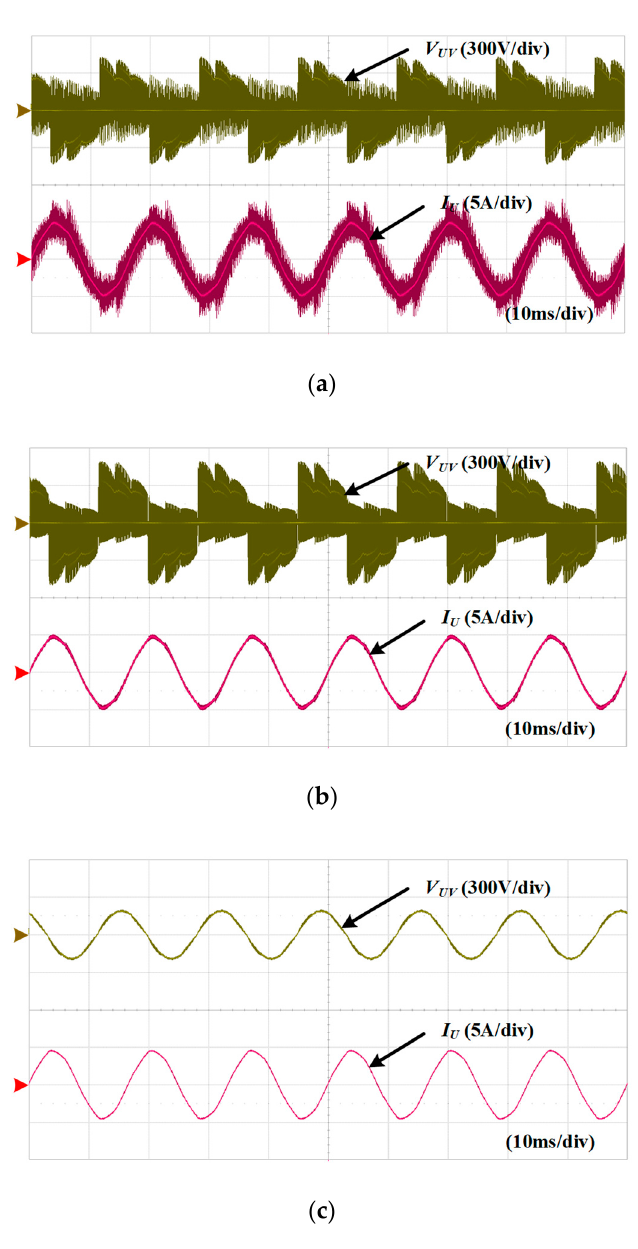
Figure 10. Experimental results of matrix converter in induction load; ( a ) without output filter; ( b ) with dv / dt filter; and ( c ) with sine-wave filter.